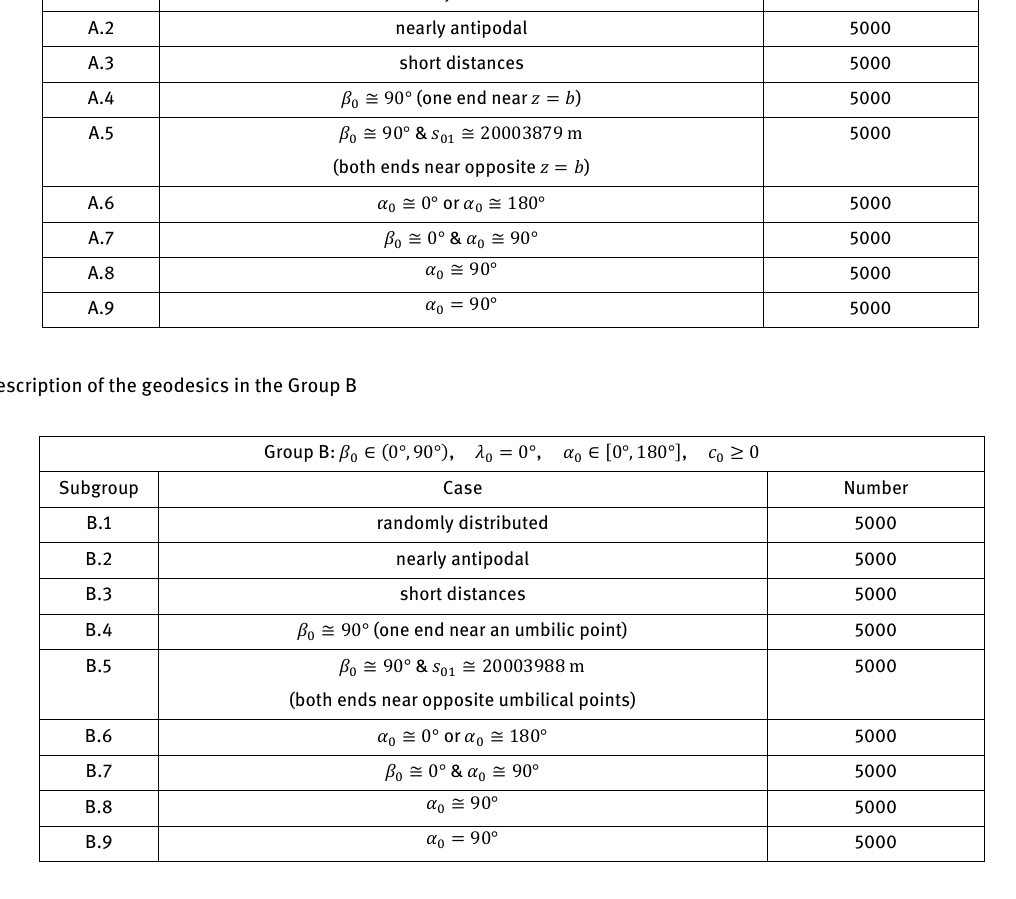
Table 7: Description of the geodesics in the Group